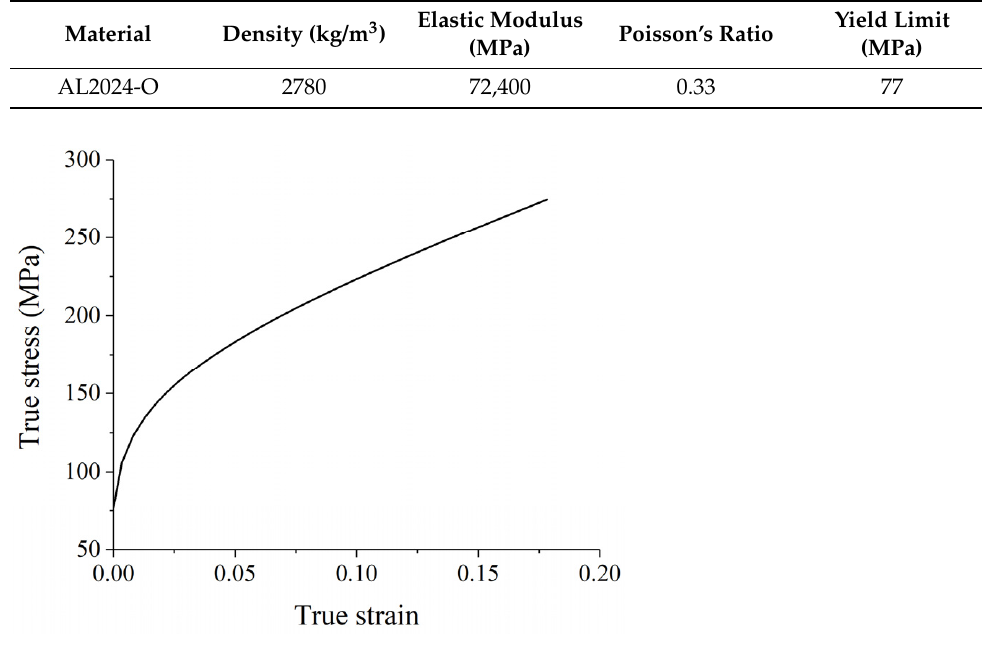
Figure 5. True stress-strain curve of AL2024-O.